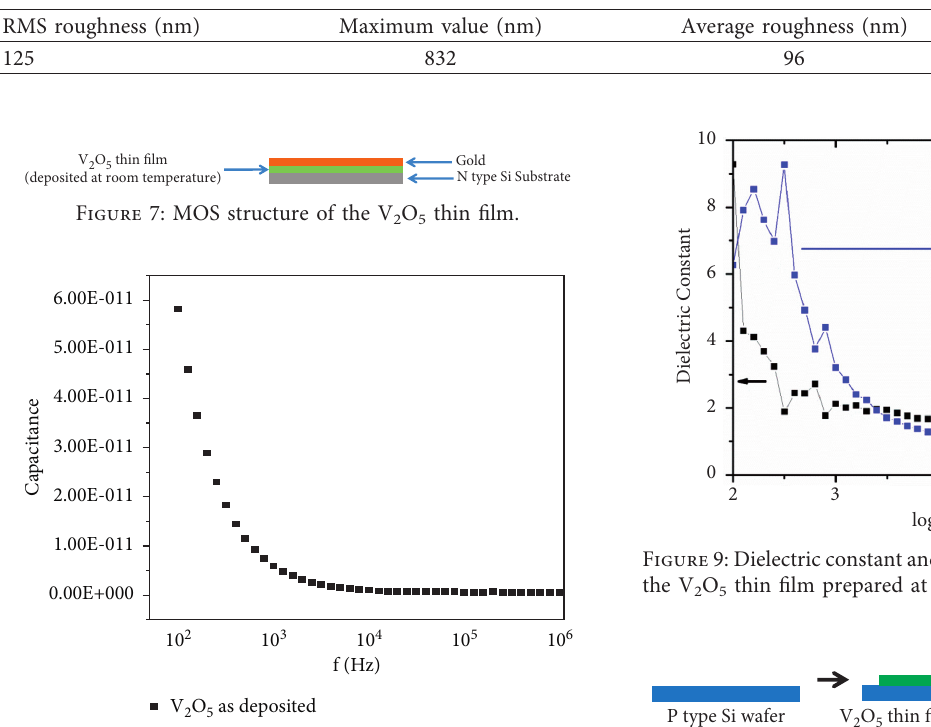
Figure 8: Capacitance vs. frequency analysis of the V prepared at room temperature.